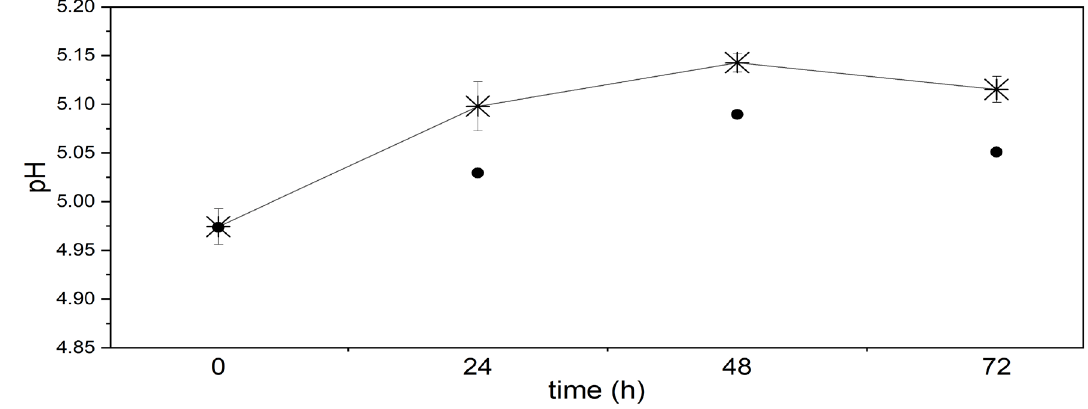
FIGURE 3 - Result of pH assay at times 0, 24, 48 and 72 h.